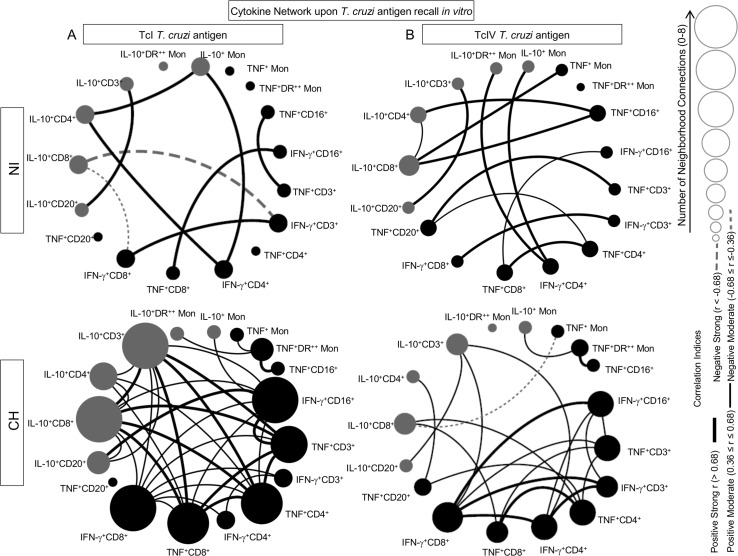
Systems biology analysis of cytokine network upon (TcI/TcIV)/T. cruzi antigen recall in vitro.Correlation matrices for cytokine+ cells were built with significant indexes and circular layouts to characterize the differential impact of (A) TcI and (B) TcIV T. cruzi antigen recall in vitro. Biomarker networks for cynomolgus macaques naturally infected with T. cruzi (CH) and non-infected controls (NI) are displayed by clustered distribution of nodes for pro-inflammatory (black node) and modulatory (gray node) cytokine patterns. Biomarker networks are displayed by node sizes reflecting the number of neighborhood connections from 0 to 8, according to the scale provided in the figure. Significant correlations (p≤0.05) were represented by connecting edges to underscore strong positive (r > 0.68; thick black line), moderate positive (0.36 ≤ r ≤ 0.68; thin black line), strong negative (r < -0.68; thick gray dashed line), moderate negative (-0.68 ≤ r ≤-0.36; thin gray equal dashed line), as proposed by Taylor [23].